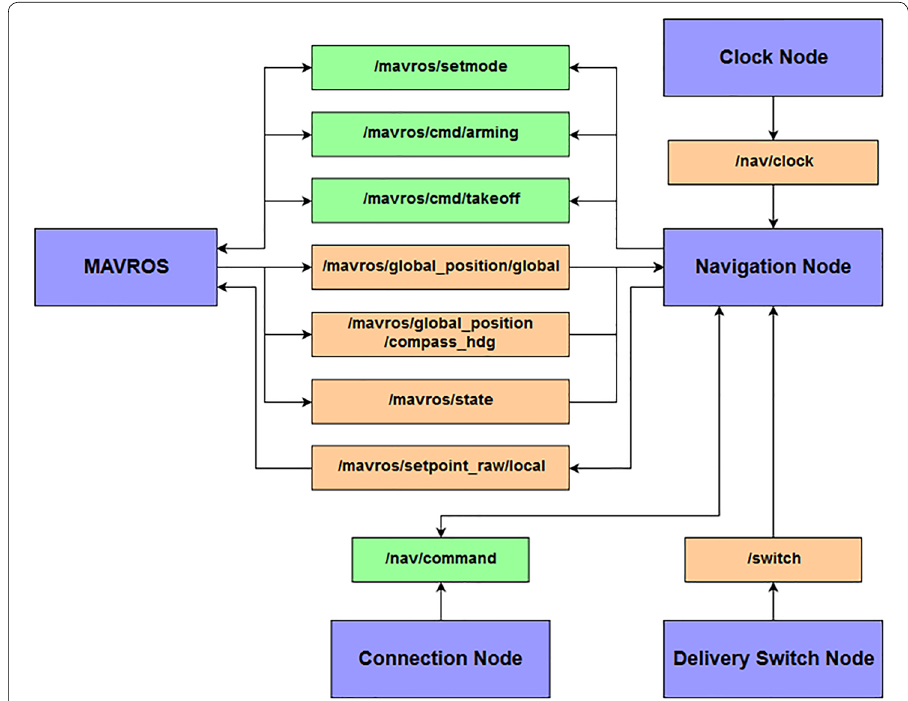
Fig. 5 Relationships between ROS nodes in our proposed